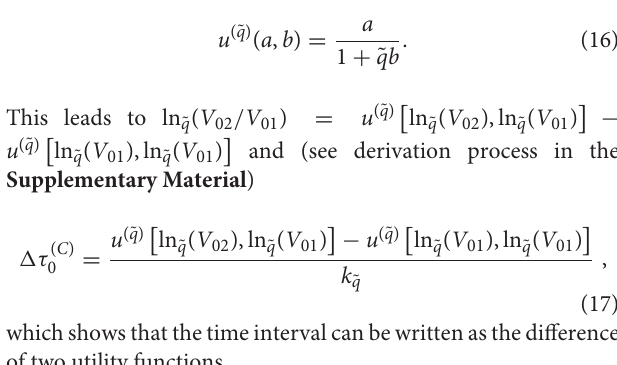
Equation (9), ln ˜ q ( V 02 / V 01 ) = ln ˜ q ( V 02 ) ⊖ ˜ q ln ˜ q ( V 01 ) with ˜ q